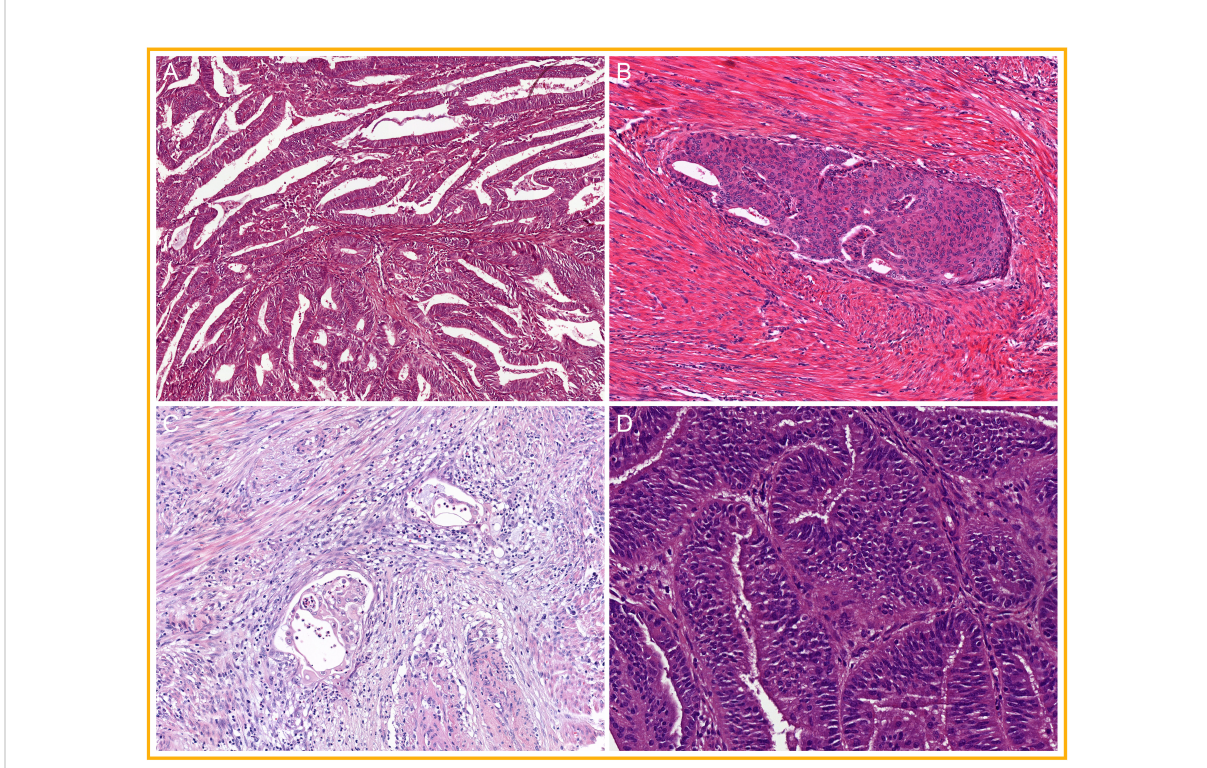
FIGURE 6 A selection of prototypical morphological features found in non-speci fi c molecular pro fi le endometrial cancer (NSMP EC): (A) glands with smooth luminal borders; (B) squamous differentiation; (C) microcystic elongated and fragmented (MELF) type of invasion; and (D) mild nuclear